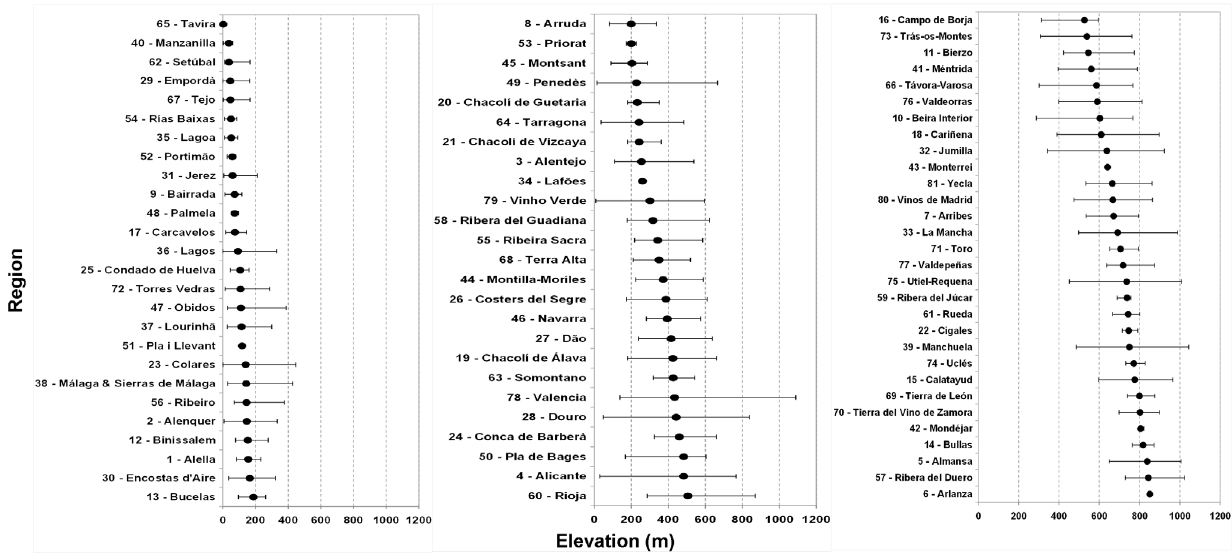
Figure 5. Elevation (m) of the vineyards in each DO/DOCa in Iberia. The inner circle represents the mean elevation and the horizontal bars represent the minimum and maximum, of the locations of the vineyards inside the DO.